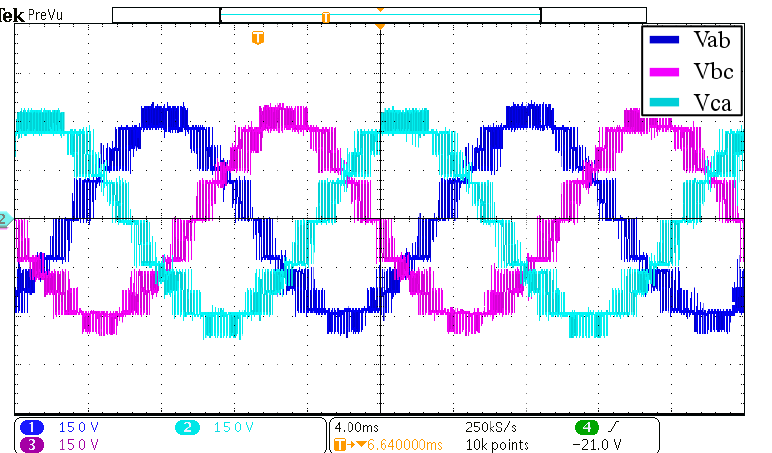
Figure 22. Experimental waveform of AHMMC output line voltages at M f = 1 tracing channels 1, 2, 3 (150 V/div).